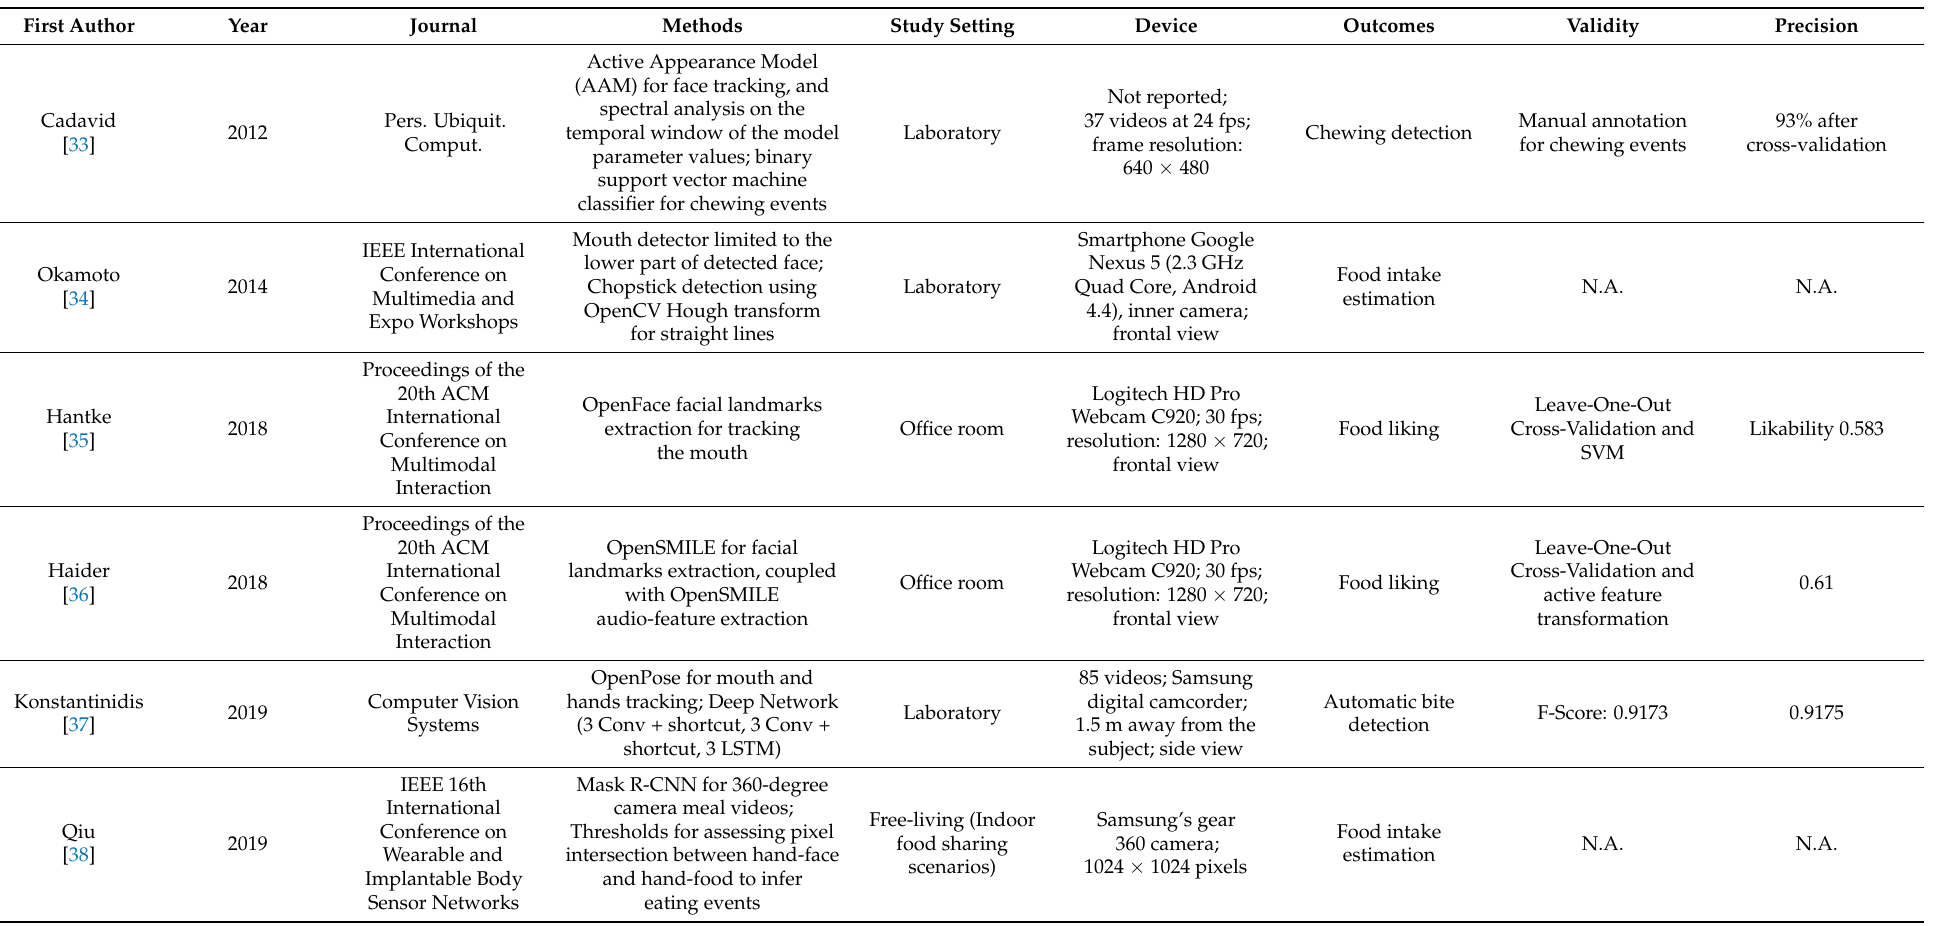
Table 1. The results table presents the publications included in this review study. The following information is summarized from left to right: first author, year of publication, journal, methods, outcomes of the study, validation method, and precision (as reported in the